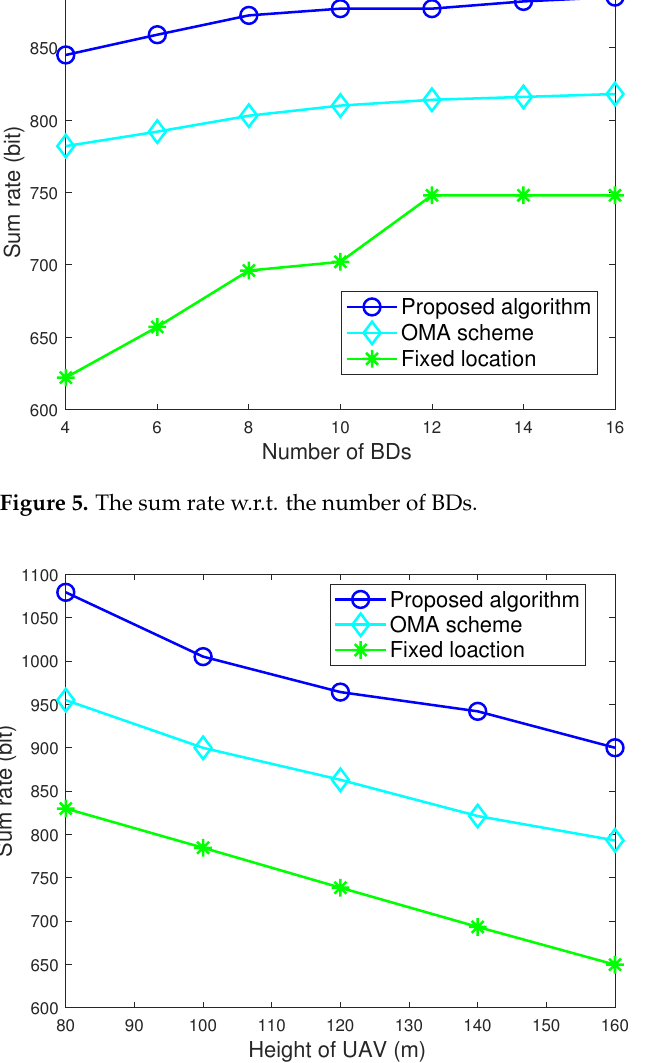
Figure 6. The sum rate w.r.s. the height of UAVs.